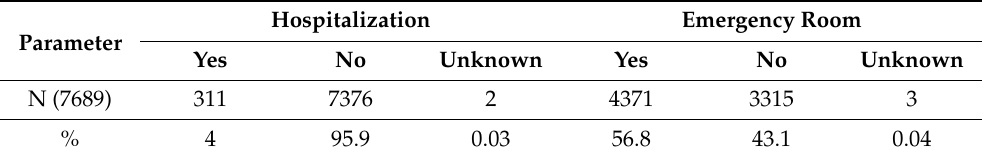
Table 3. Division by medical exigencies.